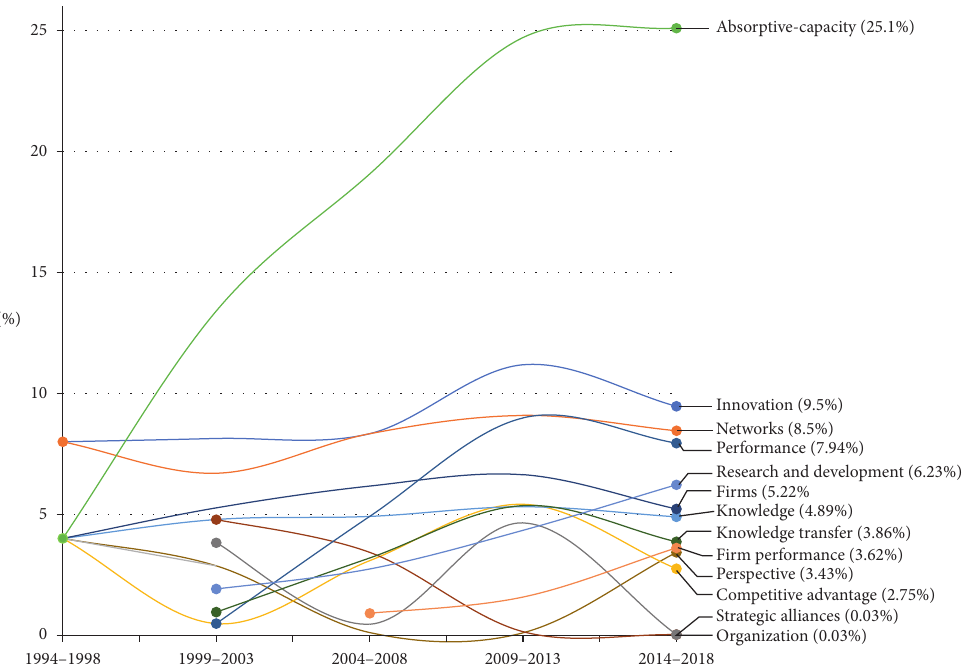
Figure 10: Normalized frequency of occurrence for each keyword among papers published in the time period considered. Source: own elaboration with Web of Science and Scopus data (2018) processed with Excel